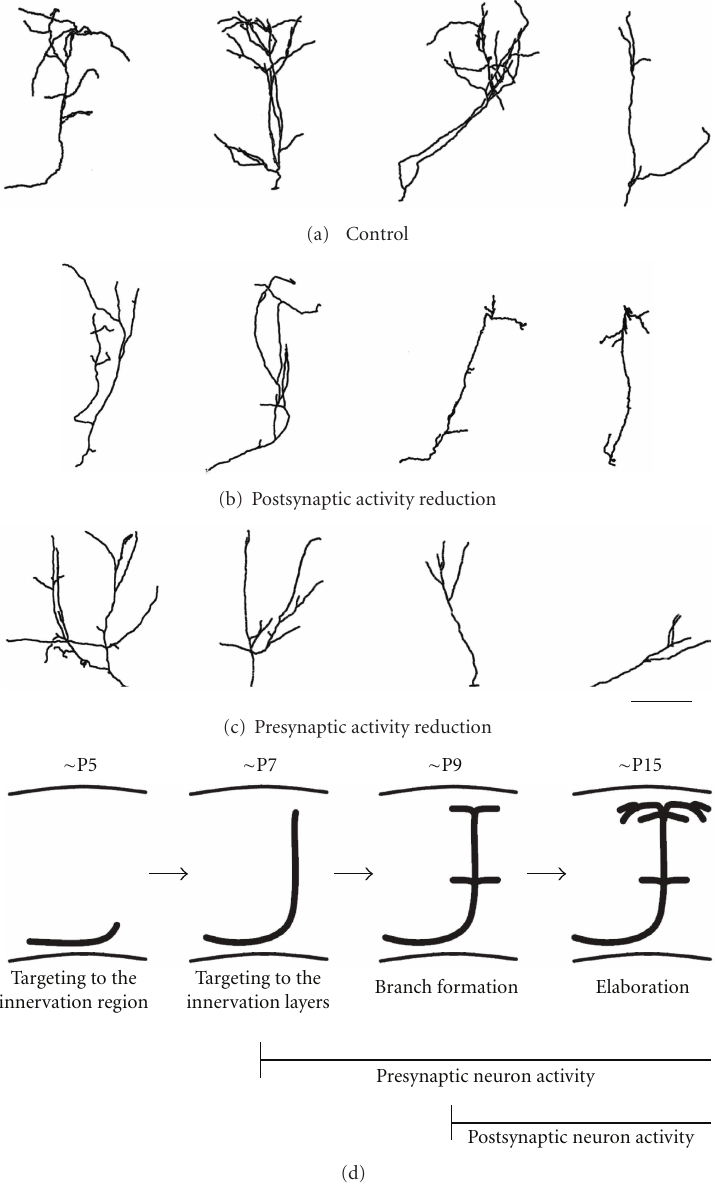
Figure 2: E ff ects of postsynaptic and presynaptic activity reduction on callosal axon projections. (a) The morphology of single callosal axons in the normal condition at P15. ((b) and (c)) postsynaptic (b) and presynaptic (c) activity reduction impede growth and branching of callosal axons. Scale bar, 200 μ m. (d) An illustration showing the development of callosal axons in the mouse. Callosal axons reach the target innervation area around P5, arrive in the target cortical layers at P7, start to branch at P9, and elaborate their arbors afterwards. The e ff ect of presynaptic activity reduction is apparent before axons reach the target cortical layers, but that of postsynaptic activity reduction is observed after their arrival in the target layers. Adapted from